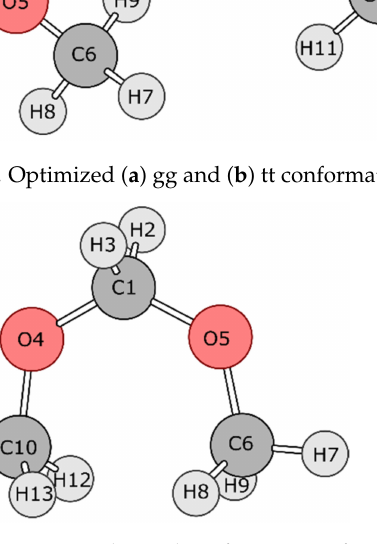
Figure 2. Optimized initial conformation of DMM with both dihedral angles at 0 degrees. The